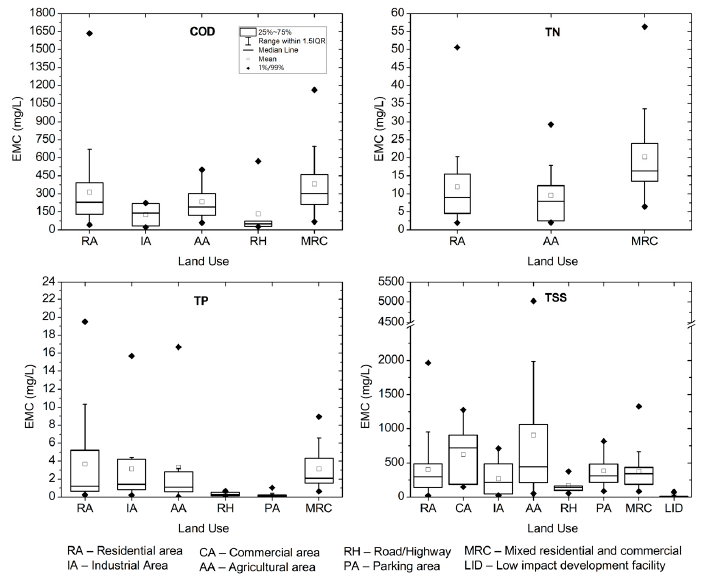
Figure 7. Summary of EMC values for each land use type gathered from the reviewed research articles on first flush.